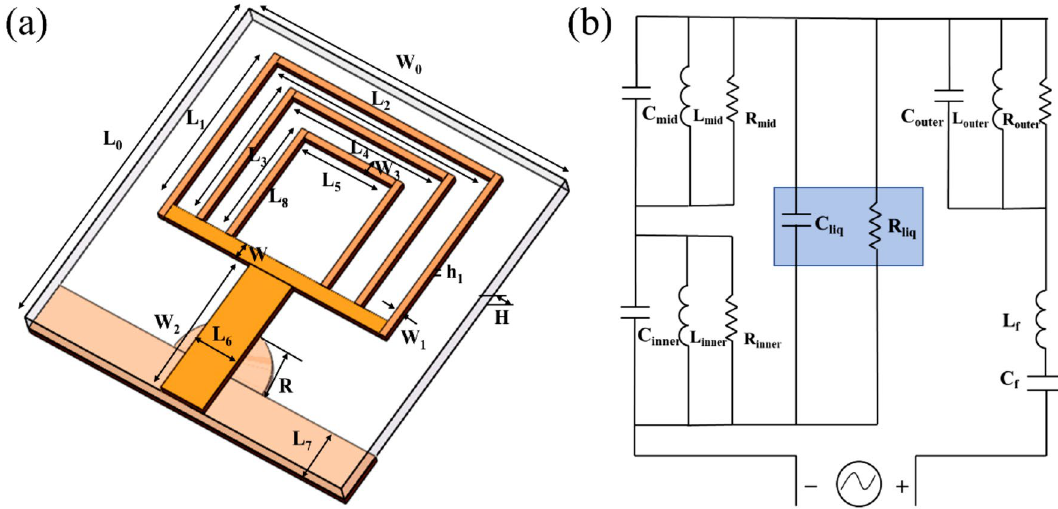
Figure 1. ( a ) The 3D structure of the triple ring patch antenna, ( b ) equivalent circuit model of the triple ring antenna loaded with the measured liquid.